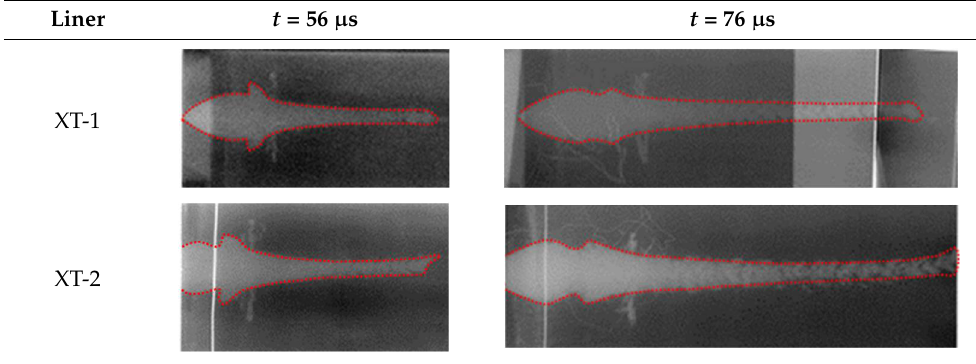
Table 1. X-ray test results.